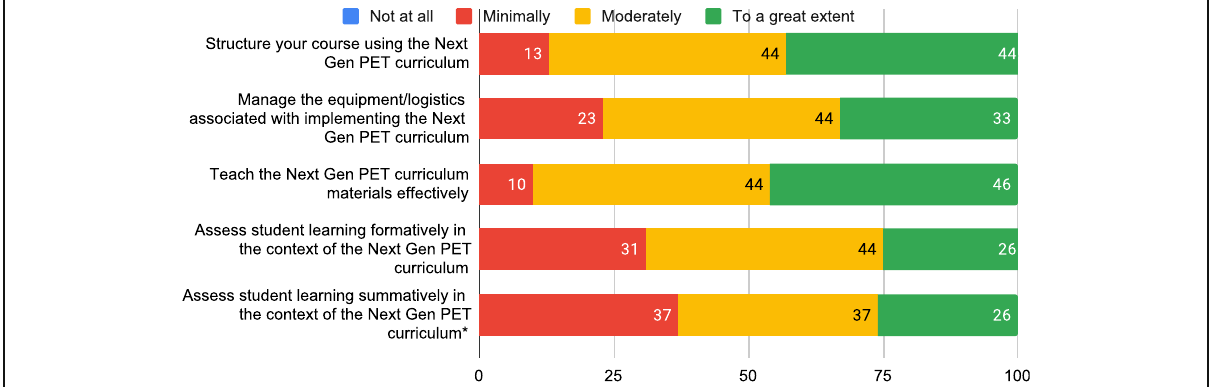
Fig. 4 Preparedness due to FOLC participation. Faculty ’ s sense of the extent to which participating in the FOLC has prepared them to use the Next Gen PET curriculum, as of spring 2019 (end of year 2 of the FOLC). N = 39, except for * item where N = 38. Respondents were asked to rate “ To what extent has participating in the FOLC prepared you to do each of the following ” on a four-point scale: Not at all; Minimally; Moderately; or To a great extent. Numbers superimposed on the bars are the percentage of respondents choosing that option. No respondents selected “